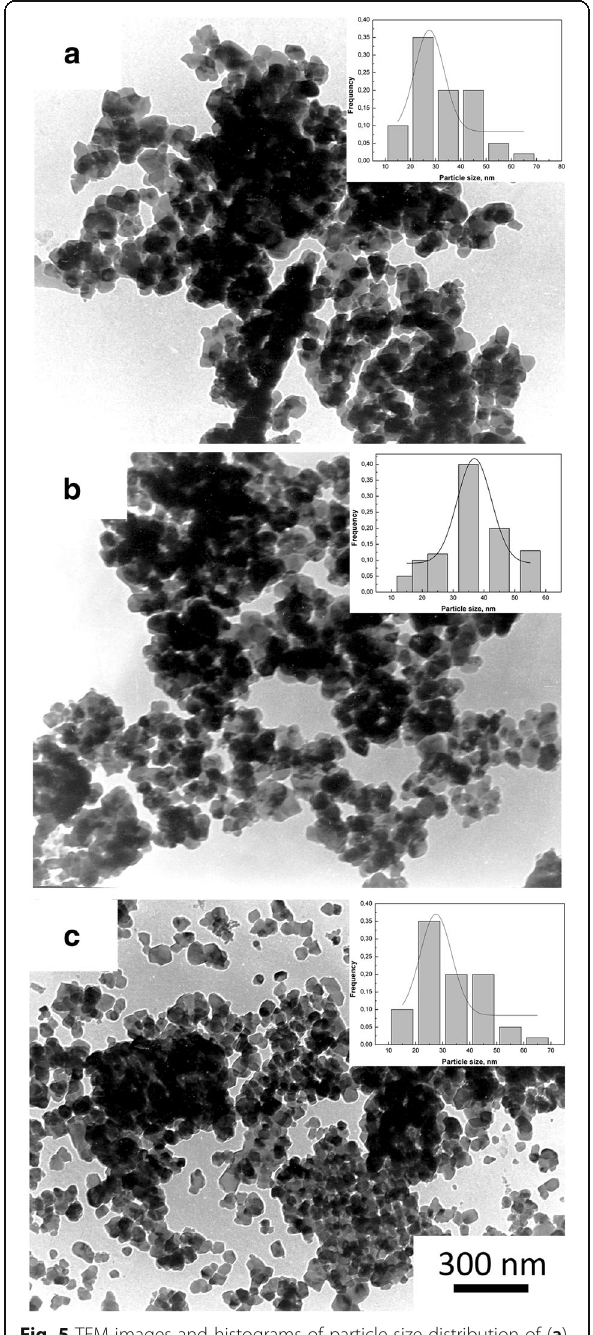
Fig. 5 TEM images and histograms of particle size distribution of ( a ) 3Y-TZP-0.2 wt% SiO 2 , b PMM4-3Y-TZP-0.2 wt% SiO 2 , c PMM8-3Y-TZP- 0.2 wt% SiO 2